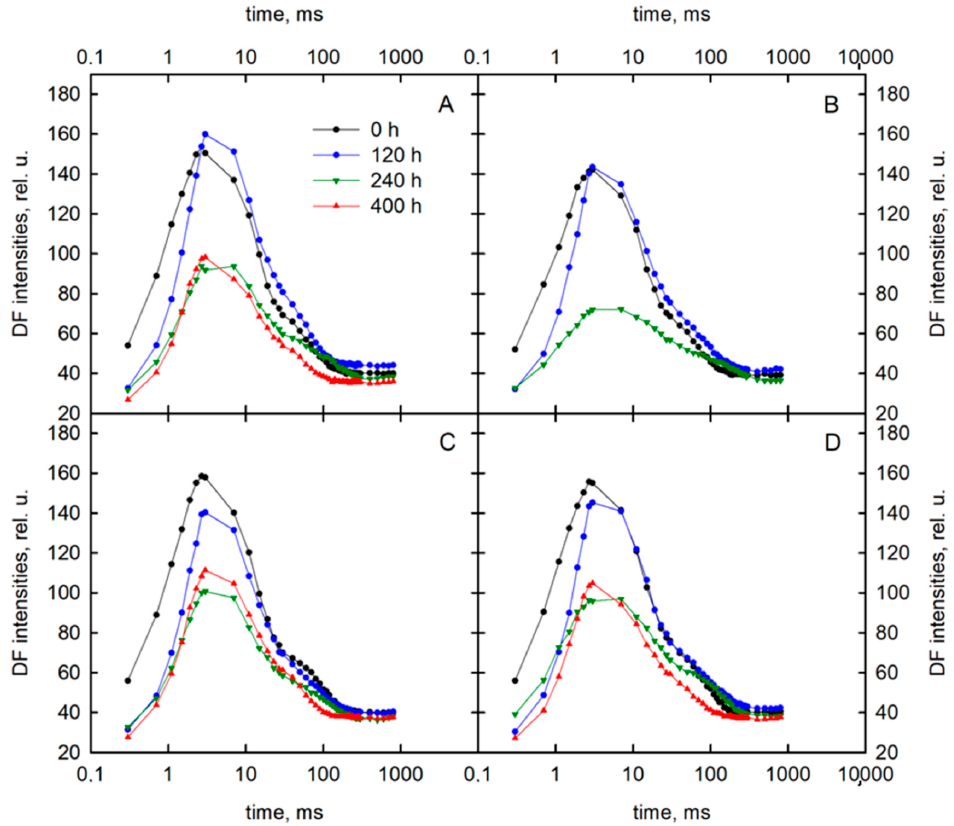
Figure 4. Delayed fluorescence induction curves of perennial ryegrass varieties (Roadrunner and Nira) under di ff erent field water capacities of soil (50 and 30% FWC) and times (0, 120, 240, and 400 h after stress application): ( A ) Roadrunner under 50% FWC, ( B ) Roadrunner under 30% FWC, ( C ) Nira under 50% FWC, ( D ) Nira under 30% FWC. n = 6. Relative